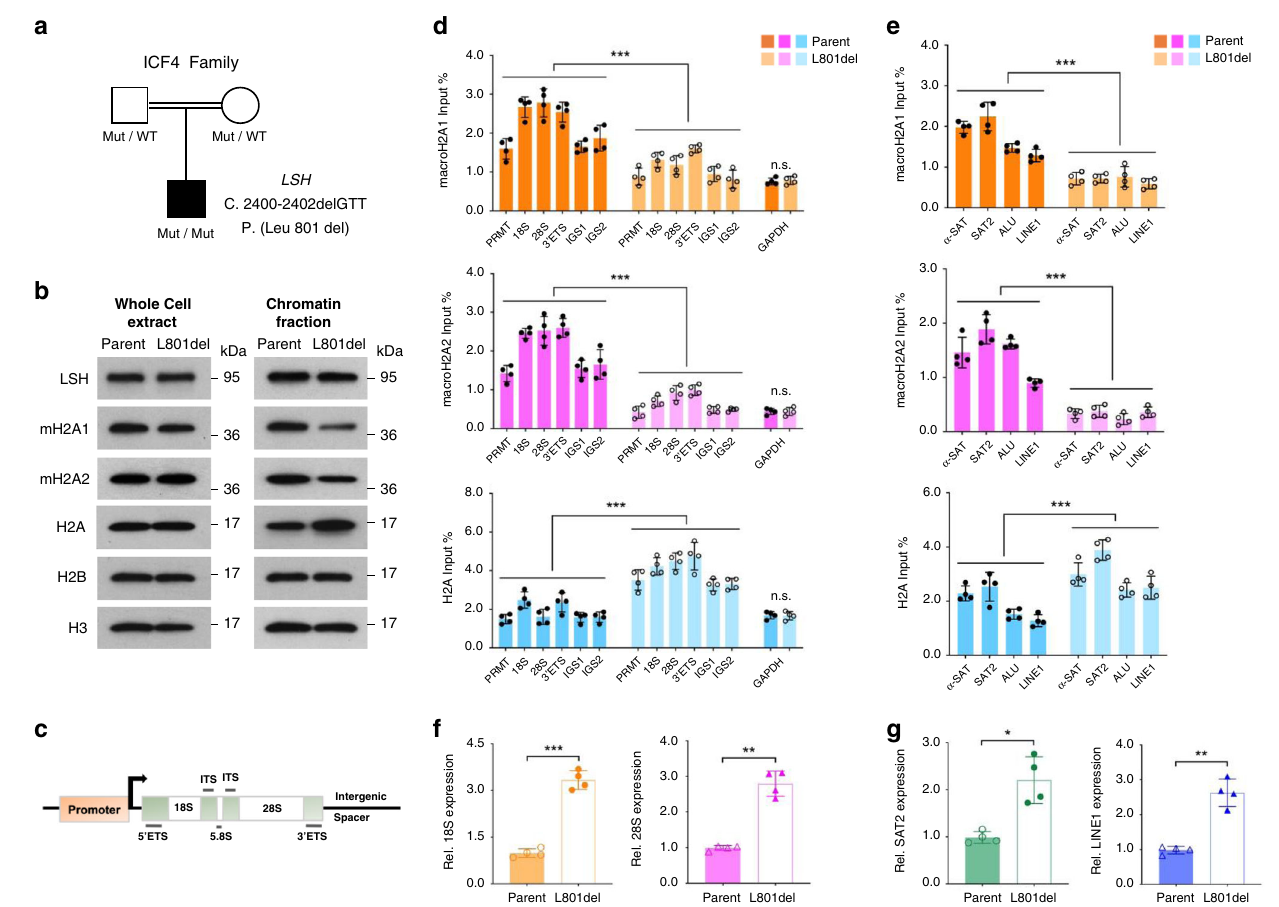
Fig. 7 Human ICF4 mutant cells display impaired macroH2A deposition associated with transcriptional de-repression at repeats. a Schematic representation depicts a human homozygous Leu 801 del (L 801 del) LSH mutant ICF4 patient family tree. Both parents are heterozygous for the mutated allele. b Western blot analysis for detection of indicated proteins in whole-cell extract or chromatin fraction isolated from ICF4 (L 801 del) patient and parental (Parent) lymphocyte cells. c , d Schematic representation of human rDNA repeated locus ( c ). PRMT promoter, ETS external transcribed spacer, ITS internal transcribed spacer, IGS intergenic spacer. ChIP-qPCR analysis shown in d for detection of macroH2A1, macroH2A2 and H2A enrichment at rDNA sequences in ICF4 patient cells compared to parental control cells. *** p < 0.0001. e ChIP-qPCR analysis for detection of macroH2A1, macroH2A2 and H2A enrichment at repeat sequences (satellite sequences, ALU and LINE1 elements) in ICF4 (L 801 del) and parental cells. *** p < 0.0001. f , g RT-qPCR analysis for detection of transcriptional levels at rDNA (18S, *** p = 0.0003; 28S, ** p = 0.0051; f ) and repeats (SAT2, * p = 0.0104; LINE1, ** p = 0.0048; g ) in ICF4 mutant cells compared to parental lymphocyte cells. Data are represented as mean ± SD. Paired two-tailed Student ’ s t test ( d – g ). d – g representative of four independent experiments. Source data are provided as a Source Data fi